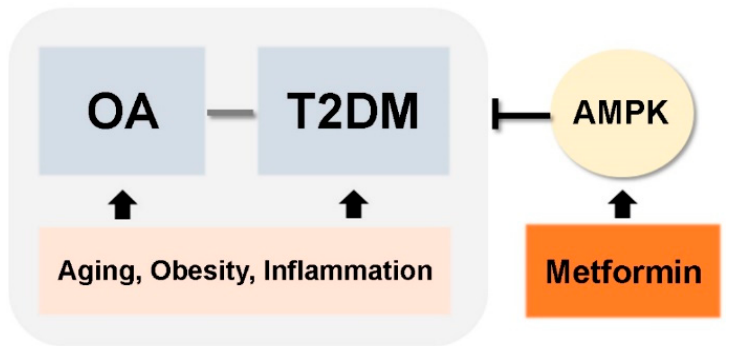
Figure 3. Simplified schematic of therapeutic applications of metformin for OA and T2DM.